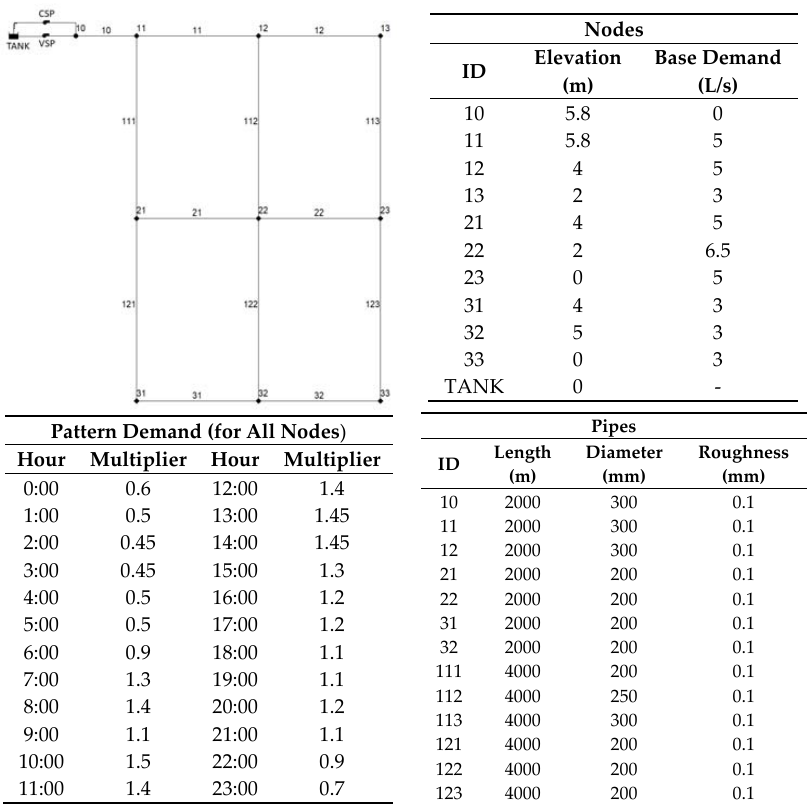
Figure 5. PWTS case study (adapted from [17]).